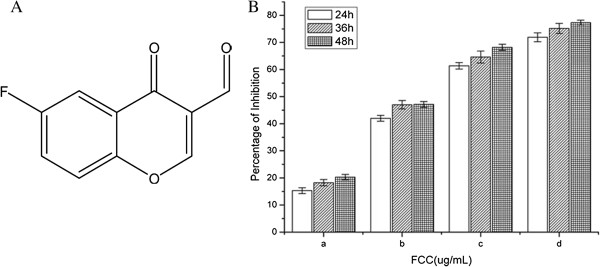
FCC Inhibited Cell Proliferation of SMMC-7721 cells. (A) Chemical Structure of FCC. (B) Viability of SMMC-7721 cells treated with FCC. MTT assay was performed to measure cell growth inhibition rate at 24 h, 48 h and 72 h after FCC treatment. Data shown were representatives of three experiments.